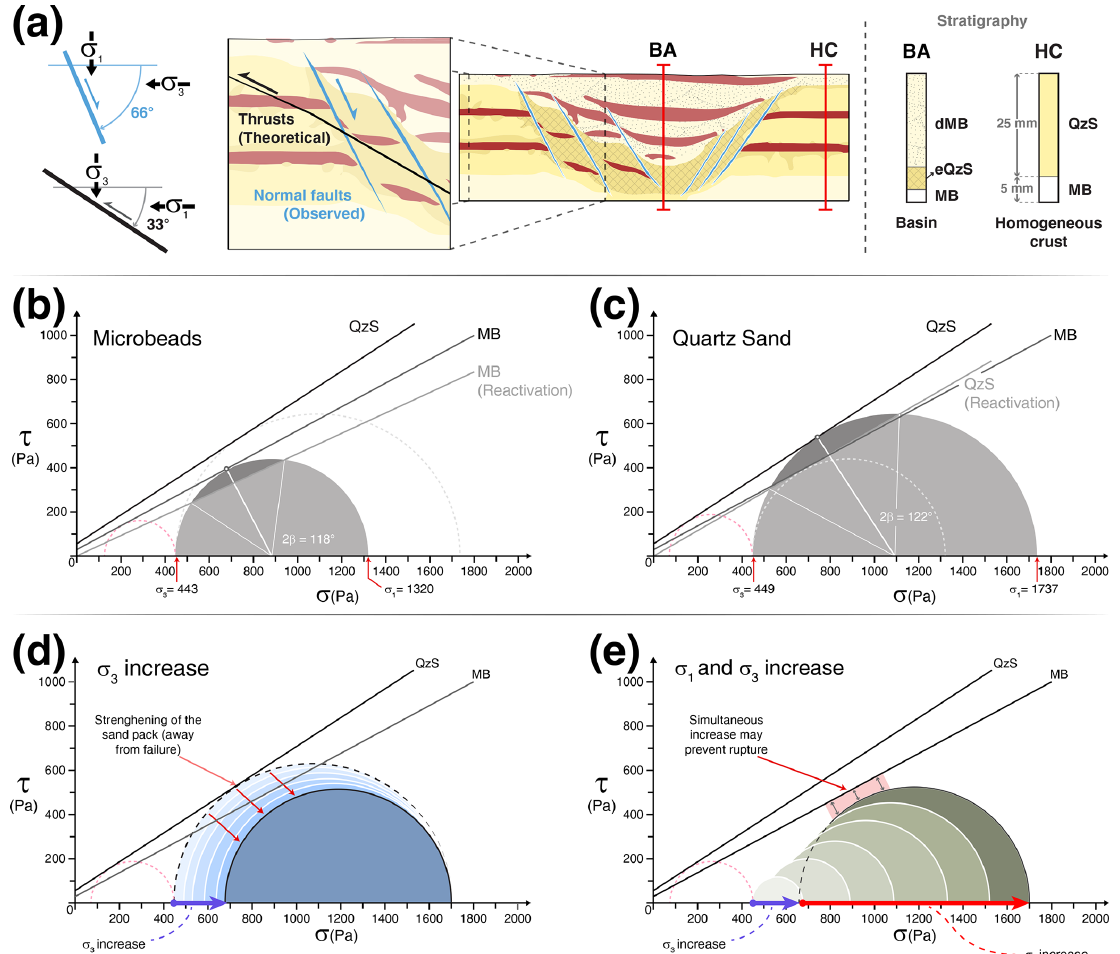
Figure 3. Mohr plots representing stress state at the base of a 3cm thick layer of (a) microbeads and (b) quartz sand (dotted red lines indicate the stress state in the extensional phase; β = angle of the failure plane). (c) Inset showing the state of the crust after extension and before the onset of compression, including observed (light blue, extensional) and theoretical (black, contractional) faulting and their spatial relationship with principal stresses σ 1 and σ 3 . The right panel shows a schematic representation of stratigraphic columns for extensional basins (BA) and homogeneous crust (HC). Thicknesses of the syn-rift sediments, extended crust, and basal microbead layer are not included as they vary slightly between basins and experiments. (d) Schematic representation of Mohr circle theoretical evolution with a σ 3 increase. (e) Schematic representation of Mohr circle theoretical evolution with simultaneous σ 1 and σ 3 increase. MB: microbeads; dMB: dyed microbeads; QzS: quartz sand; eQzS: extended quartz